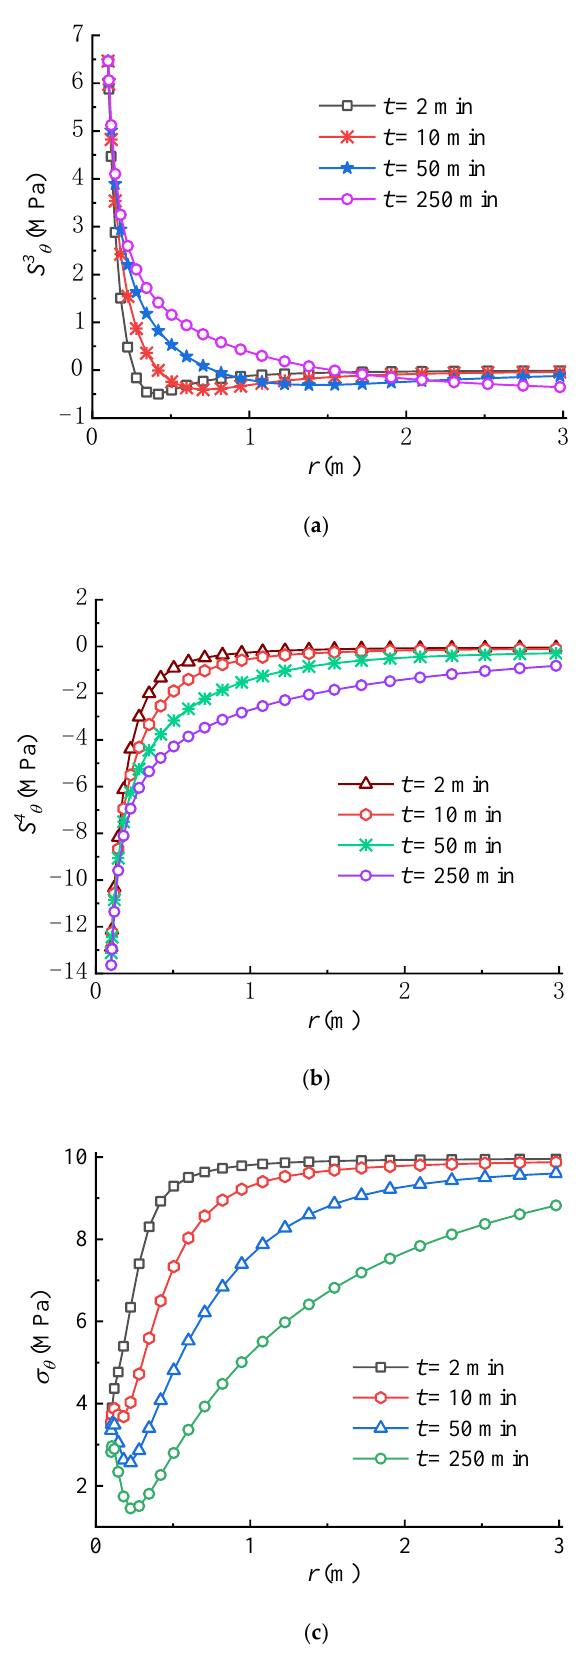
 with time ( 4 and ( c )  θ , ( b ) S θ and ( c ) σ θ with time ( p w = 15 